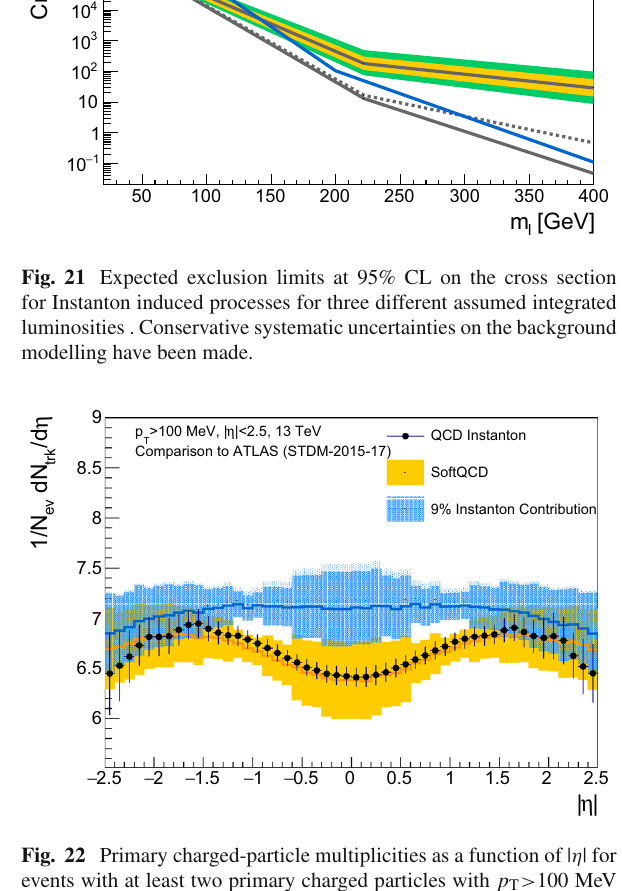
Fig. 20 Predicted distribution of the charged particle spectrum vs. η of the Monash softQCD tune of Pythia8 as well as a modified ver- sion with significantly enhanced multiple parton interaction probability ( MPI:alphaSvalue = 0.150 ) in comparison to the measurement at 7 TeV of the ATLAS Collaboration [55]